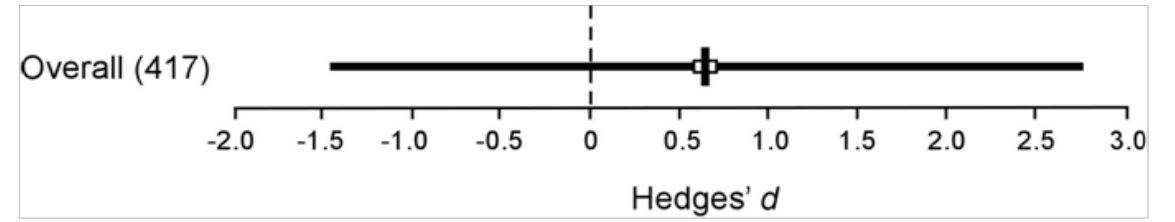
F IGURE 2. Approximately 95% of the 417 values of Hedges’ d reported in R-G’s Tab. S2 fall within the range shown by the dark horizontal bars around the mean value of 0.65, shown by the vertical bar. By way of contrast, the small rectangle around this mean value represents the 95% confidence interval of the mean as displayed in Fig. 1a of